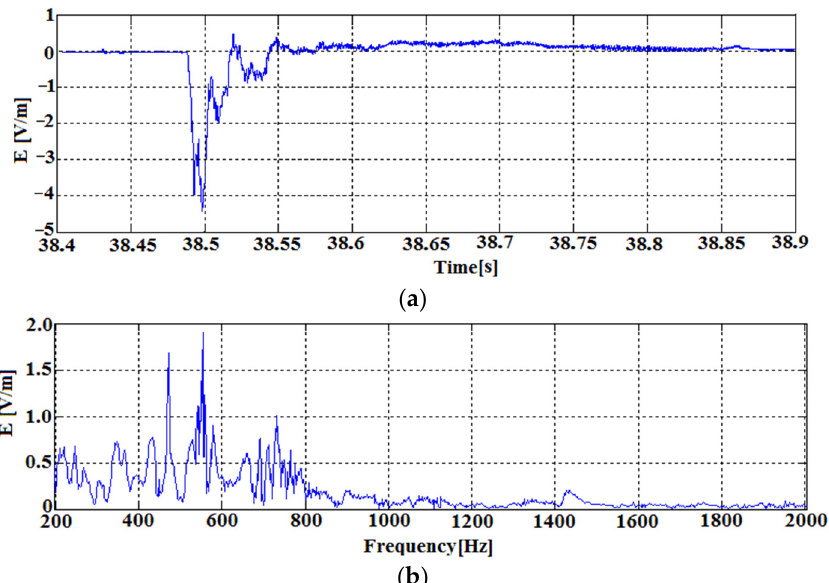
Figure 11. The first of the recorded pulses from Figure 10 at 38.4 to 38.9 s. ( a ) time course; ( b ) spec- trum of the